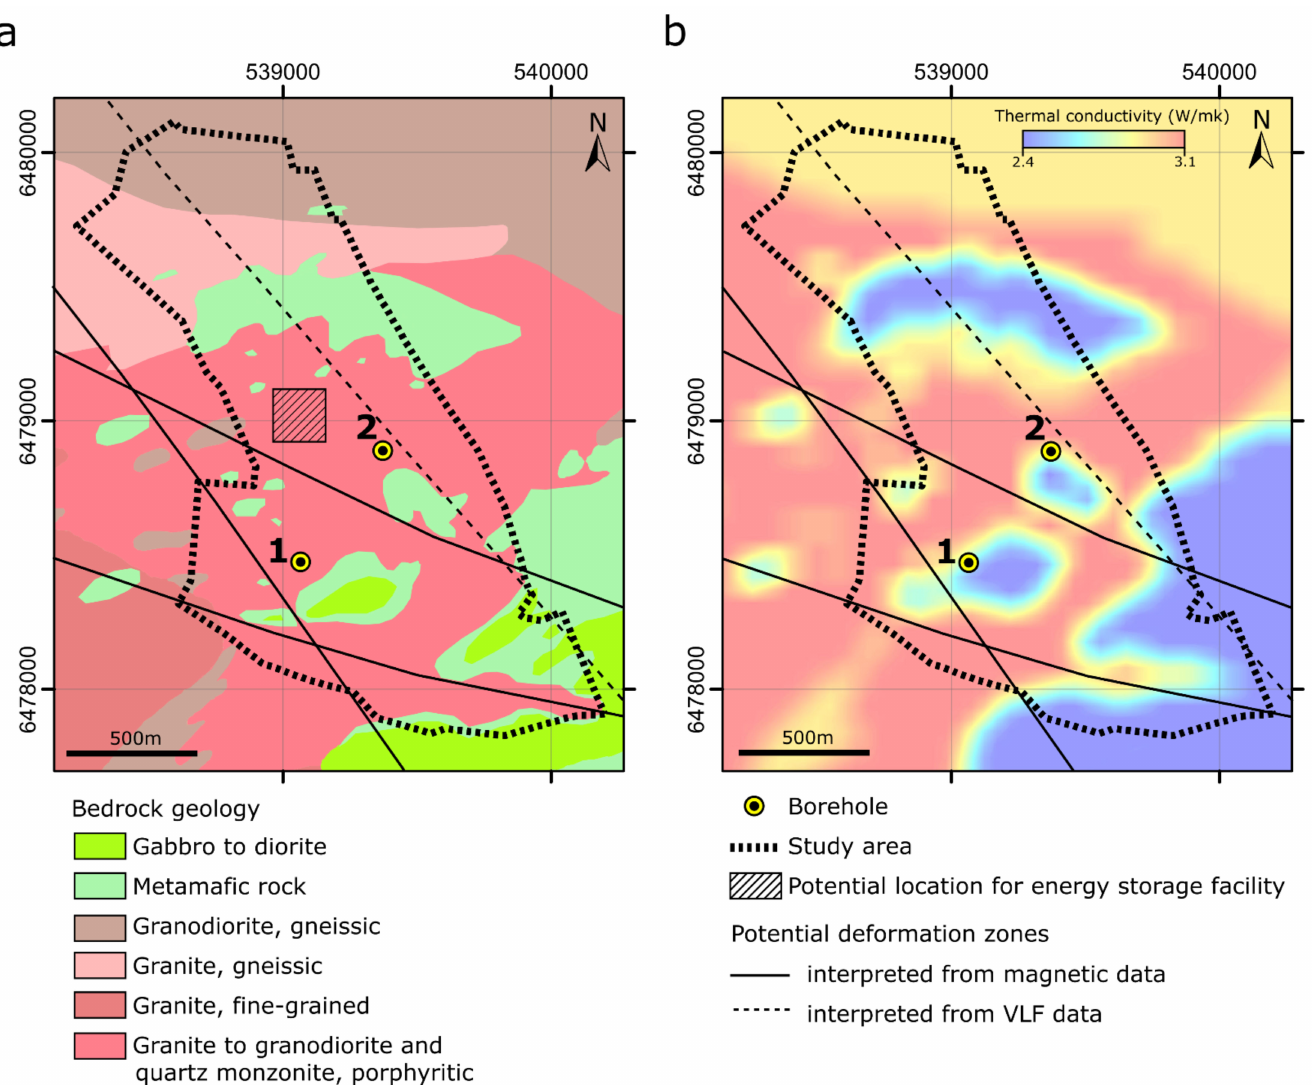
Figure 8. ( a ) Interpretation of the Bedrock geology based on geological and geophysical observations made in this study. A potential location for the energy storage facility is highlighted. ( b ) A map showing the prognosed bedrock thermal conductivity based on the data and observations from this study. Borehole 1: Distorp Hagen, 2: Distorp